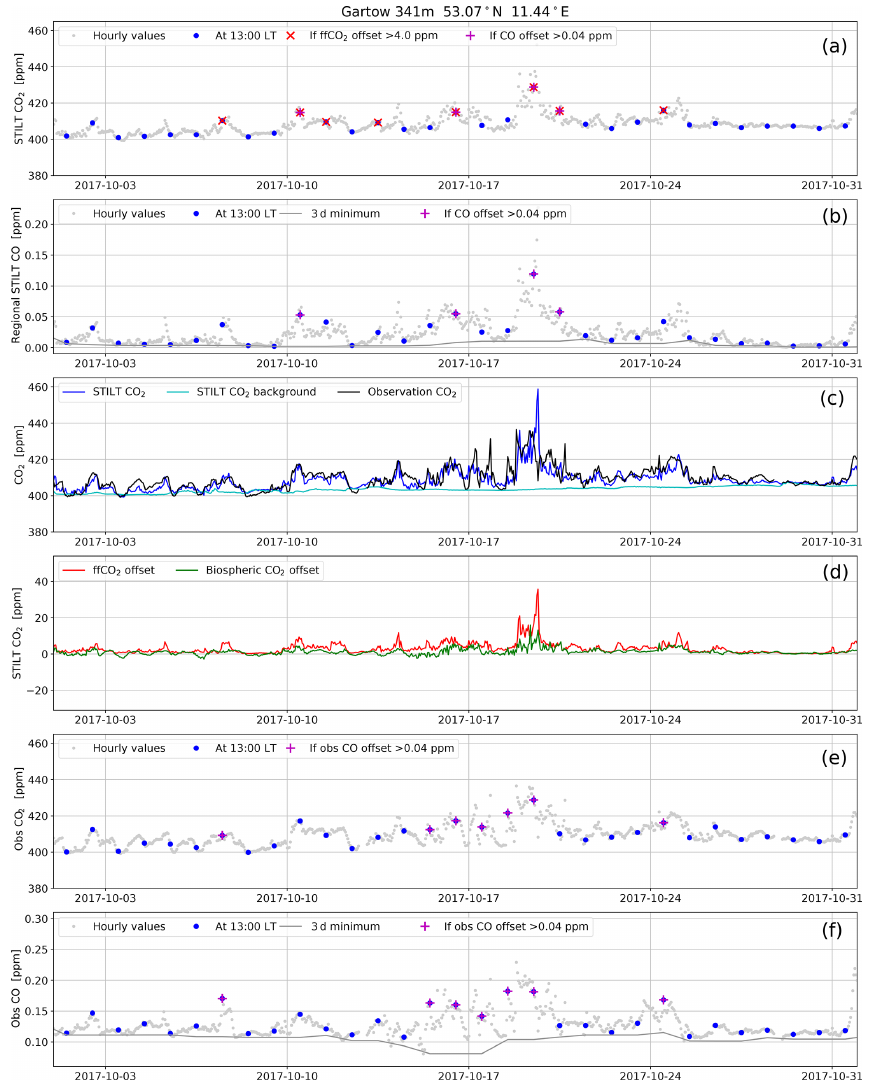
Figure 8. Same as Fig. 7 but for October